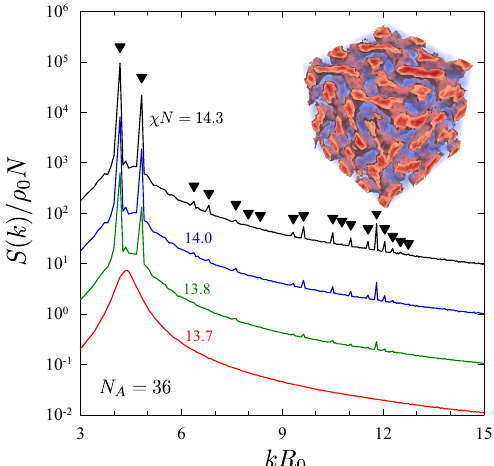
Figure 5. Structure function, S ( k ) , at a sequence of χ N values, calculated for diblocks with N A = 36 and N B = 54. For clarity, the curves for the ordered states exhibiting peaks are shifted up by an integer number of decades. The morphology (see inset) and peak positions (triangles) confirm that the ordered state is gyroid. Reproduced from Ref.